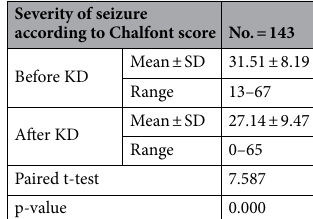
Severity of seizure according to Chalfont score No. = 143 Mean ± SD 31.51 ± 8.19 Before KD